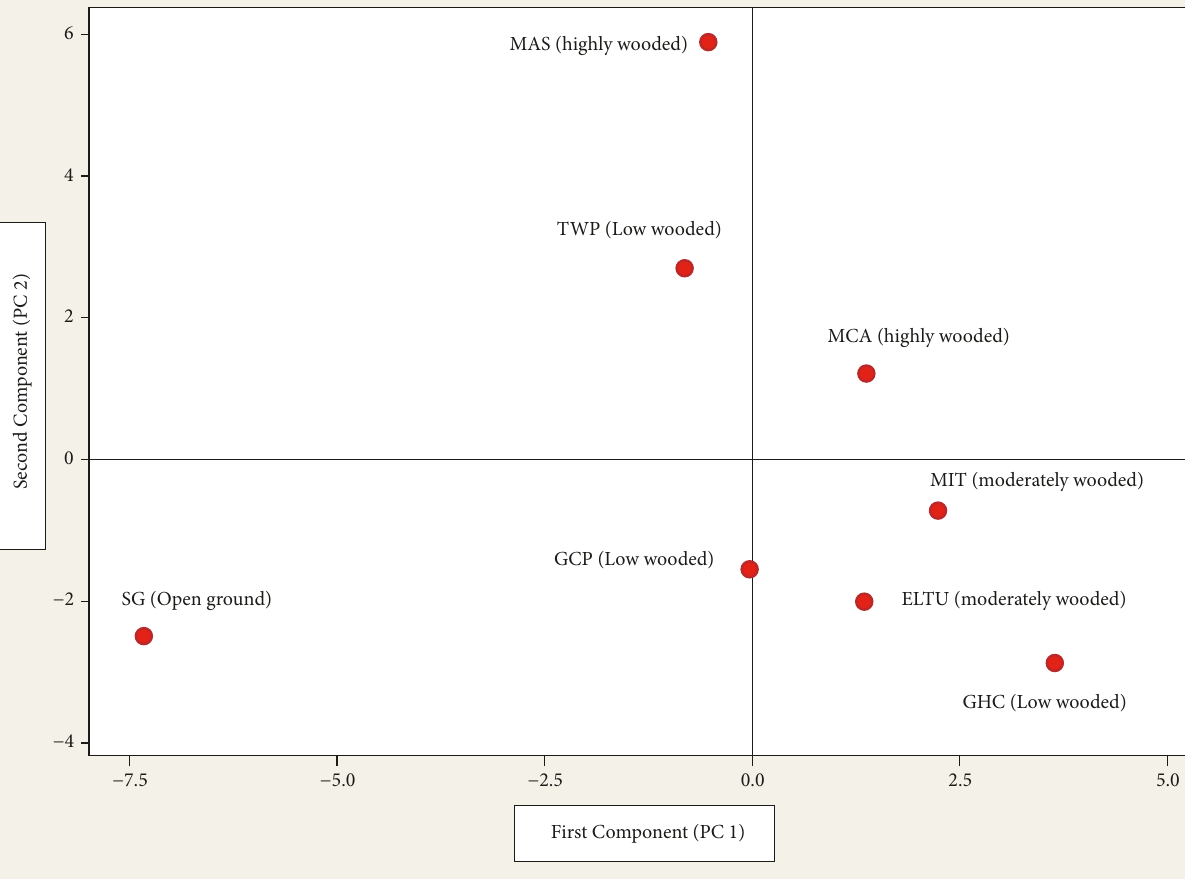
Figure 7: Ordination of the habitats based on PC1 and PC2 scores of Principal ComponentAnalysis of the abundance of avifaunaof sampling